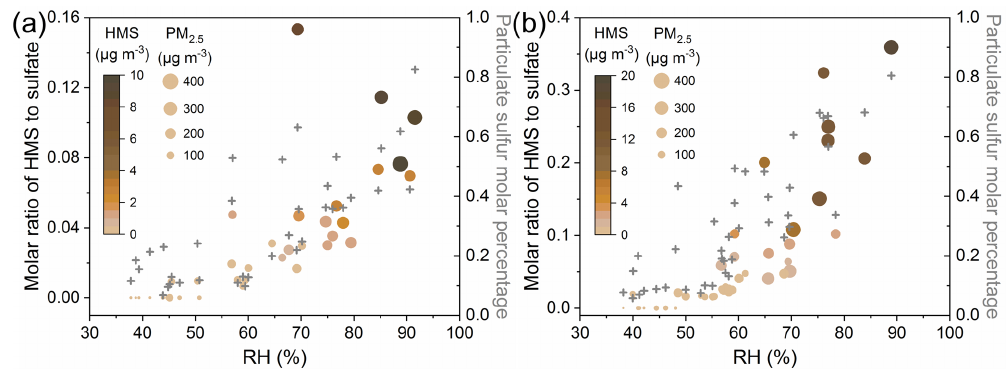
Figure 3. Evolution of sulfur distribution with the increase in RH in the winter of (a) 2015 and (b) 2016. The solid circles represent the molar ratio of HMS to sulfate, colored by the HMS concentrations and sized by the PM 2 . 5 concentrations. The gray crosses represent the particulate sulfur molar percentage. Particulate sulfur molar percentage =